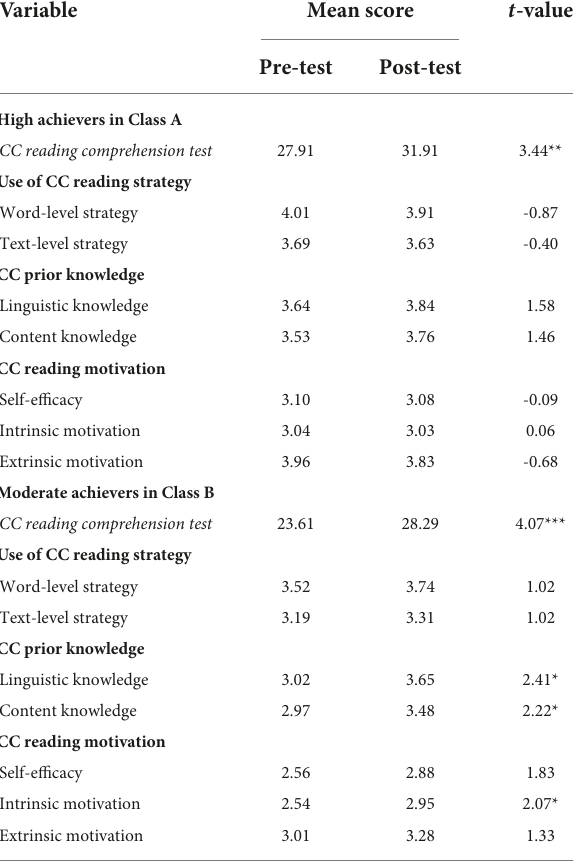
TABLE 3 Pre- and post-test comparisons within each experimental class. Variable